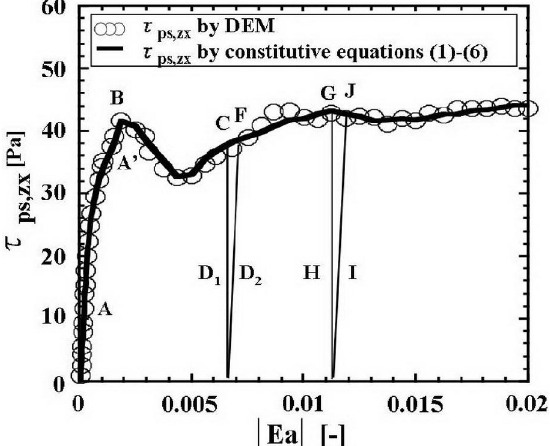
obtained by the constitutive Equations ps,zx